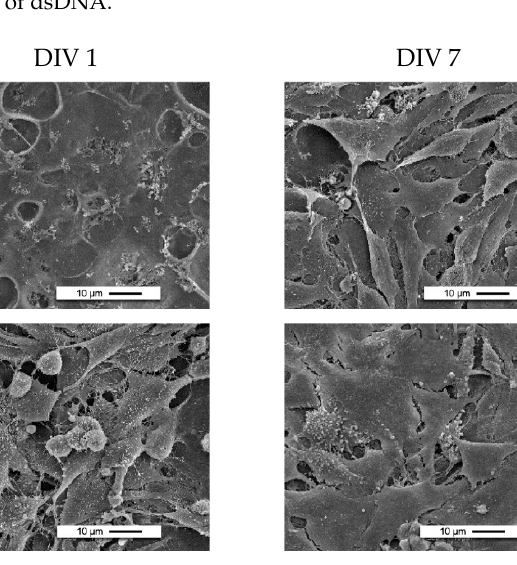
Figure 9. In vitro assessment of the biological performance of different GelMA-based hydrogels seeded with ATDC5 over cell culture time, with the correspondent statistical analysis (* p < 0.05, ** p < 0.01, *** p < 0.001, and symbols denote statistical differences when compared each of the conditions at each time point and compared with day 1 ( θ ) and day 7 ( α ). Data are presented as mean ± SD ( n = 3). ( a ) ATDC5 metabolic activity; ( b ) ATDC5 proliferation assessed by quantification of dsDNA.